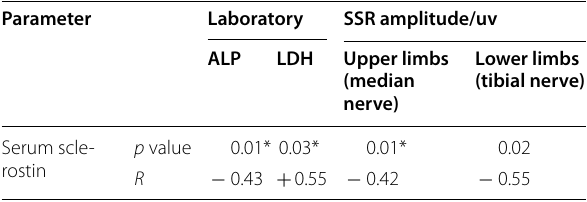
Table 4 Correlation between serum sclerostin level and different parameters